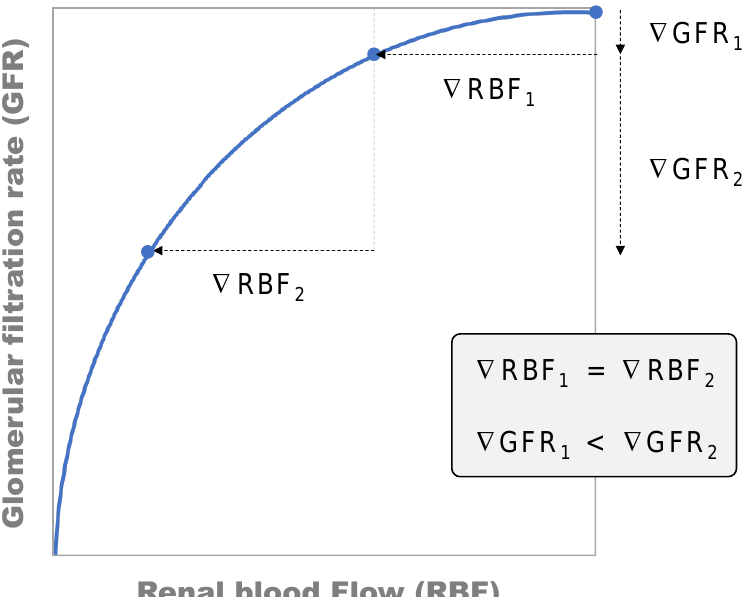
Figure 6. Effect of renal blood flow (RBF) on glomerular filtration rate (GFR) demonstrating a parabolic relationship where the reduction of GFR caused by a reduction in RBF depends on the starting point [95].